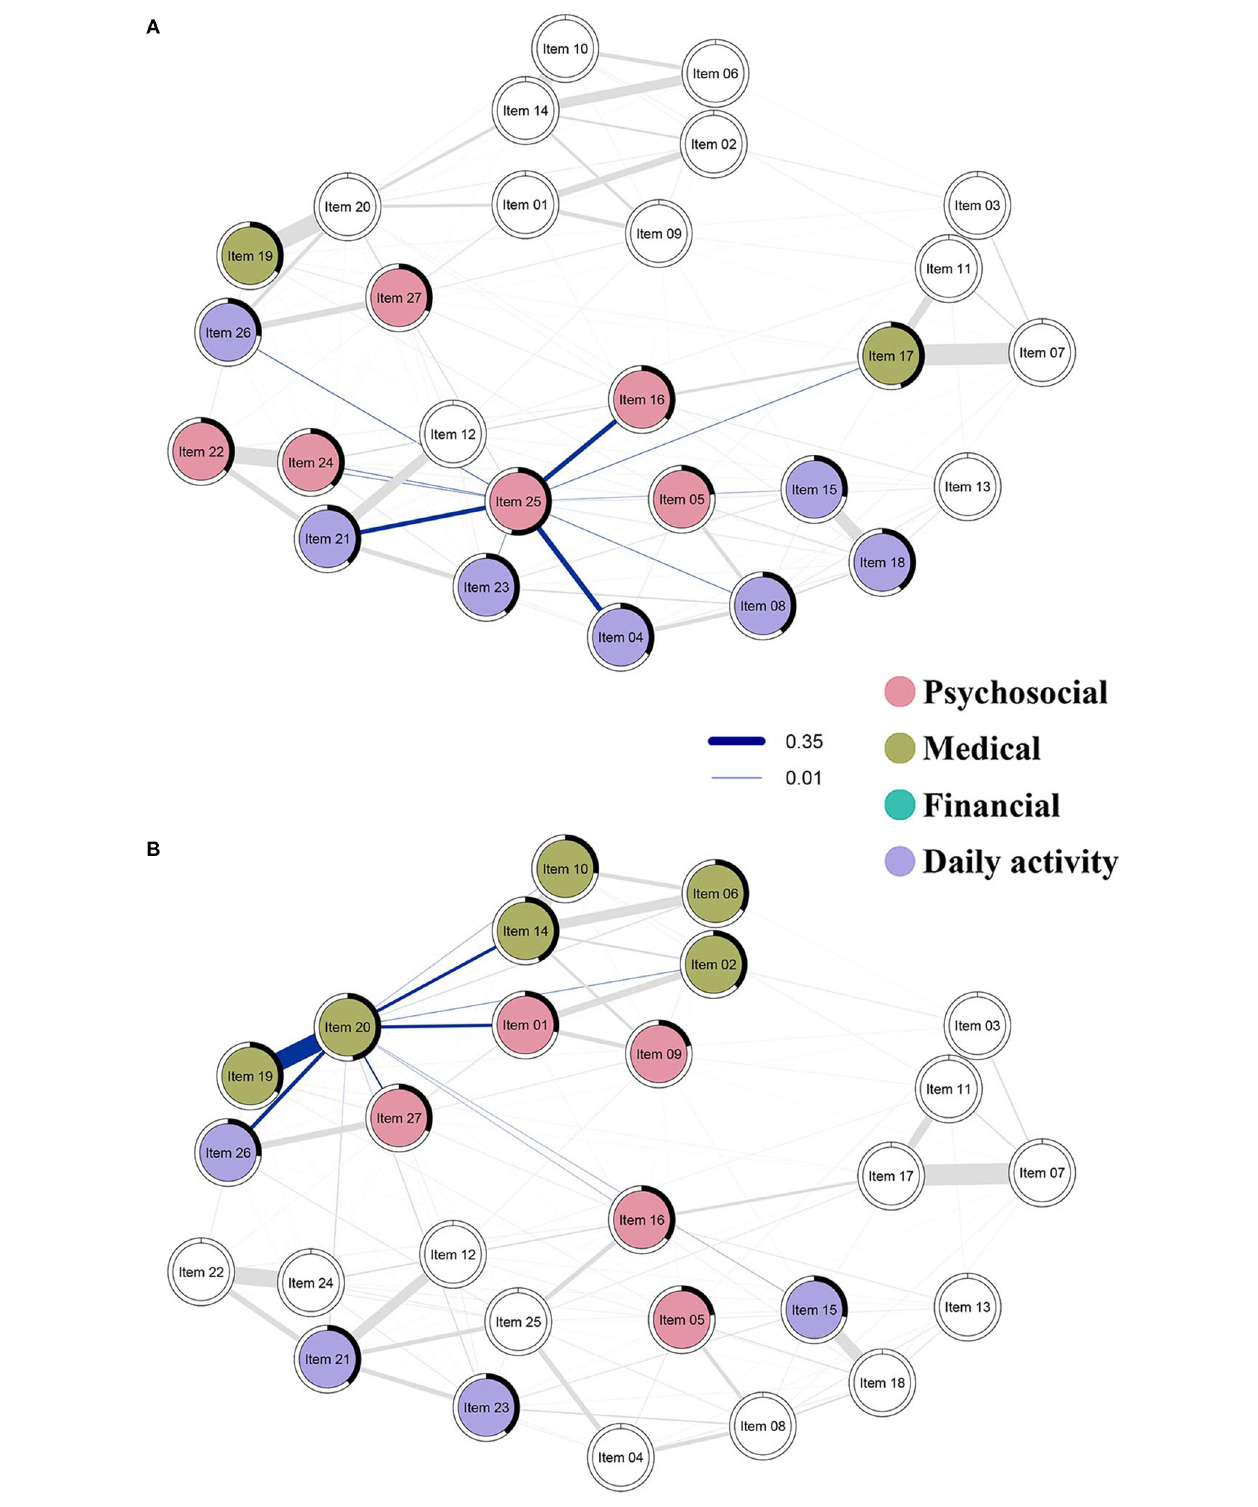
FIGURE 3 | Strength centrality and predictability of top two nodes with highest strength centrality are highlighted in this figure. Blue lines show the positive association between needs; the thickness of the lines represents the strength of the association between needs. The thicker the line, the stronger the relationship between the two needs. The black area around the rings shows the predictability, the variance of a given node explained by all its neighbors. Nodes are colored by their factors in the NAFC; psychosocial needs are colored red, medical needs are colored olive, financial needs are colored green, daily activity needs are colored purple. (A) Strength centrality and predictability of dealing with lifestyle changes (Item 25) and (B) managing other cancer-related symptoms (Item 20).